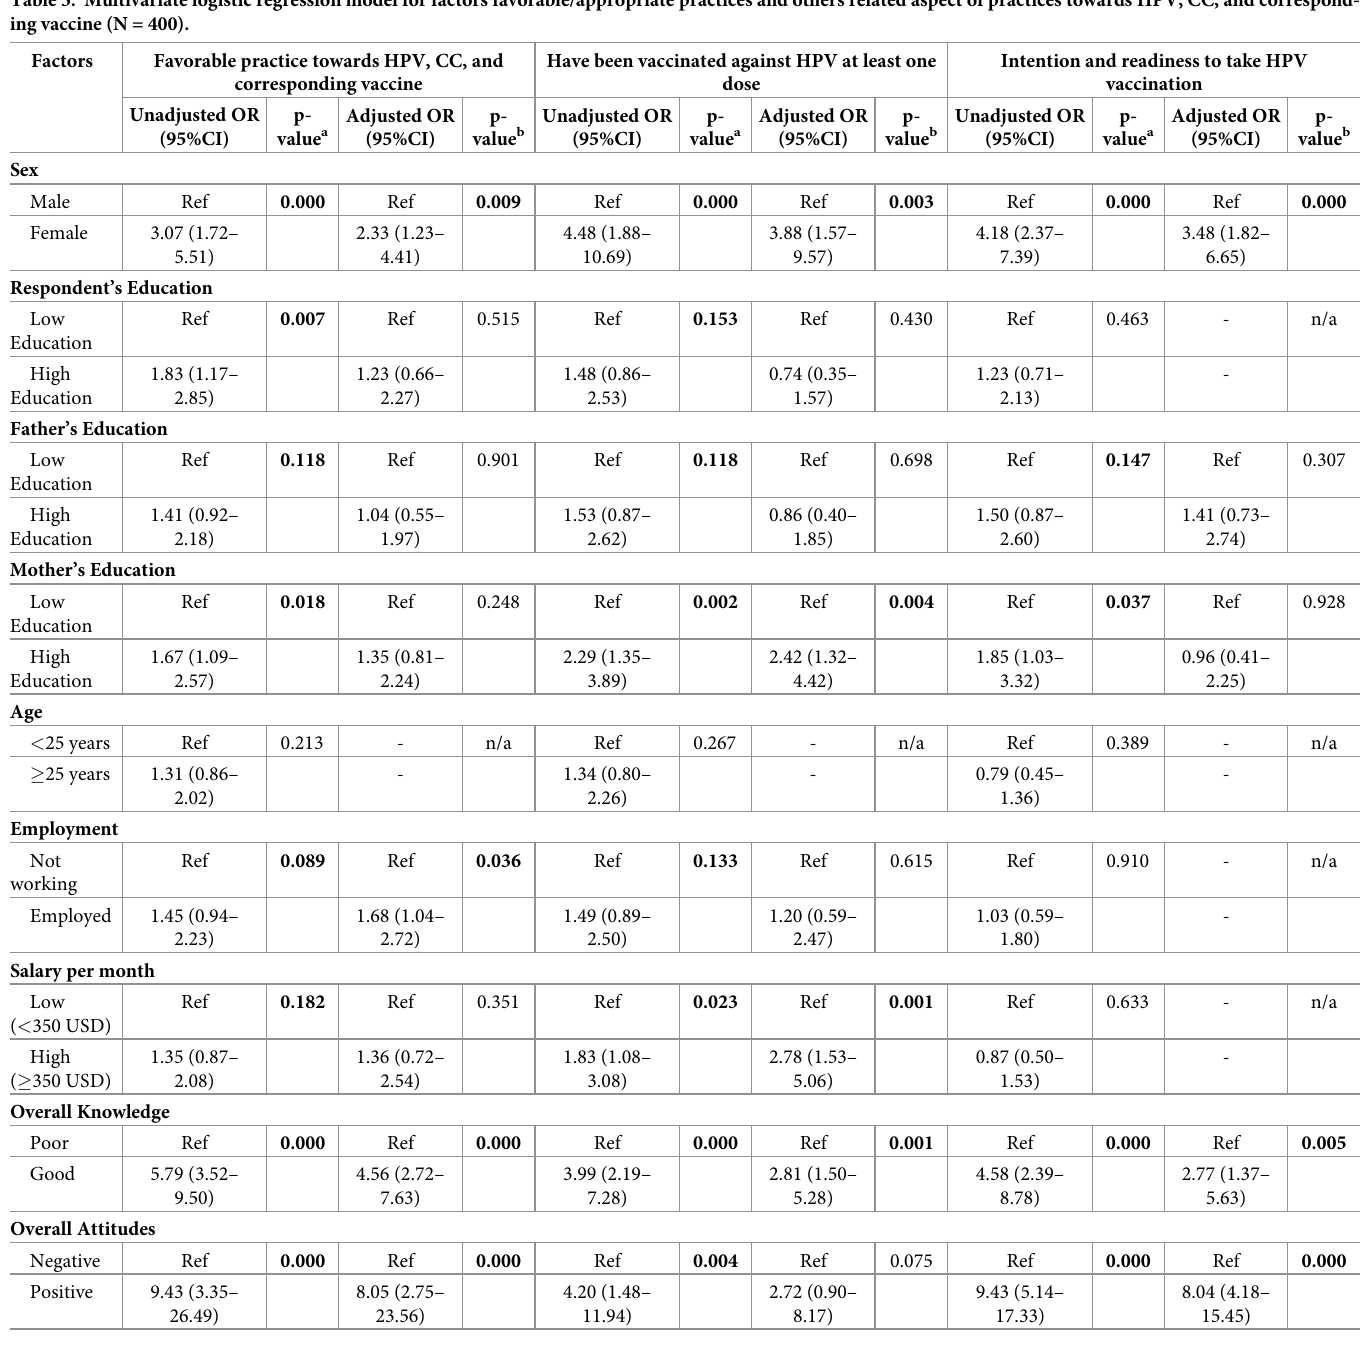
a Bivariate analysis using Chi-square and Mantel-Haenszel odds ratio estimate, any associated factors with p � 0.20 were deemed eligible for inclusion in the multivariate analysis model; b Multivariate logistic regression analysis; 95%CI (95% confidence